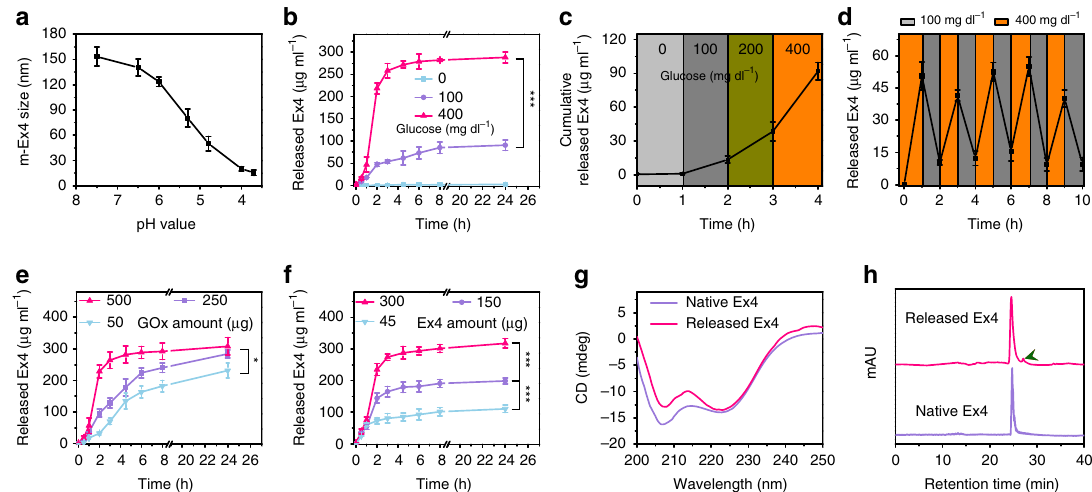
Fig. 4 In vitro glucose responsiveness of dual mineralized particle-based GRS. a m-Ex4 size change in response to pH. Mean ± S.D. ( n = 3). b Accumulated Ex4 release from dual mineralized particle-based GRS in different glucose concentrations at 37 °C. Mean ± S.D. ( n = 3). *** P < 0.001 (two-tailed Student ’ s t -test). c The increase of glucose concentration signi fi cantly elevated the Ex4 release rate. Mean ± S.D. ( n = 3). d The pulsatile release pro fi le of dual mineralized particle-based GRS presented the concentration of released Ex4 as a function of glucose concentration (100 and 400 mg dl − 1 ). Mean ± S.D. ( n = 3). e Accumulated Ex4 release from dual mineralized particle-based GRS with different amounts of GOx at 37 °C. Mean ± S.D. ( n = 3). *P < 0.05 (two-tailed Student ’ s t -test). f Accumulated Ex4 release from dual mineralized particle-based GRS with different amounts of Ex4 at 37 °C. Mean ± S.D. ( n = 3). *** P < 0.001 (two-tailed Student ’ s t -test). g CD spectrum of released and native Ex4. h HPLC analysis of released and native Ex4. Retention time is ~25 min. Arrow indicates the peak from the oxidative product of Ex4 according to the mass